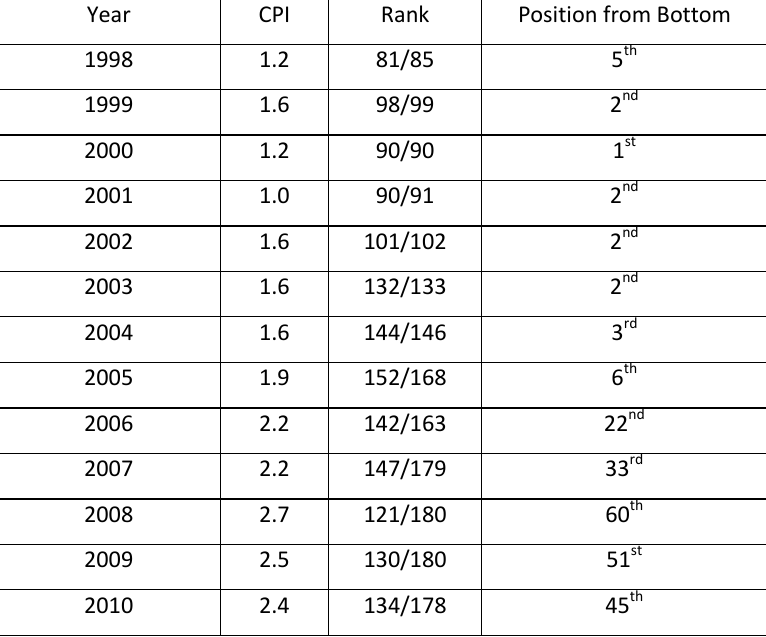
TABLE 3: N igeria’s Corruption Perception Index,